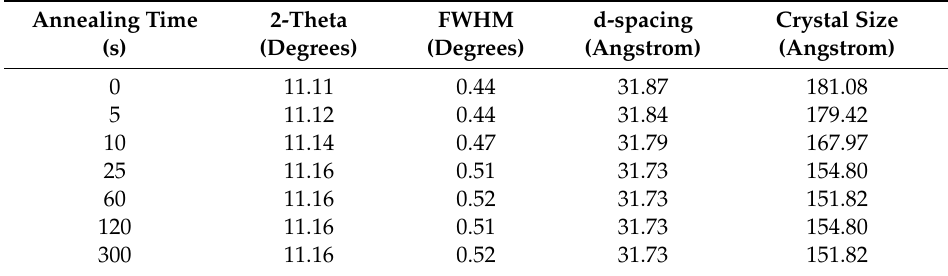
Table 2. D-spacing and crystal size calculated using the (004) di ff raction for PI fibers annealed at 400 ◦ C under di ff erent times.